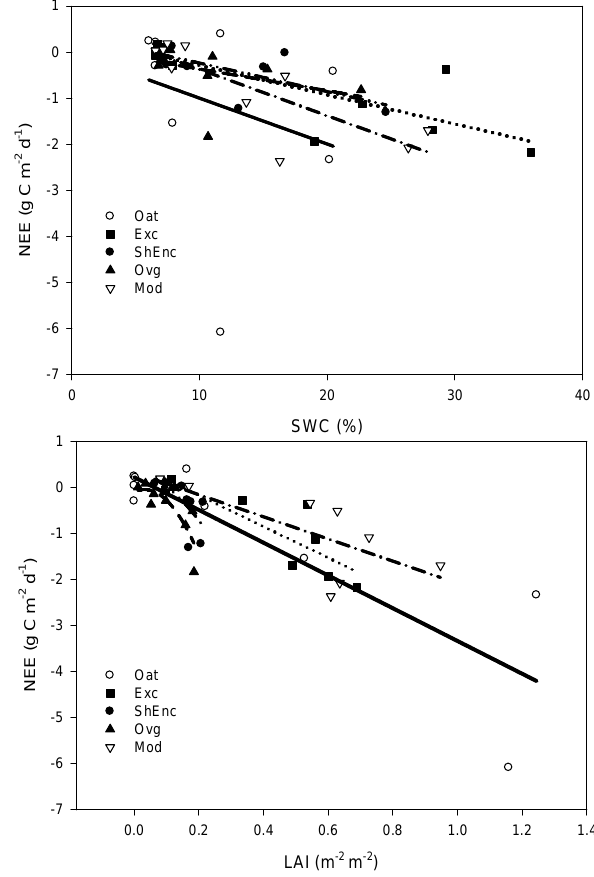
Fig. 7. (a) Linear regressions between daily daytime NEE and SWC in five contrasting land use change types measured during ten months. (b) Linear regressions between daily daytime NEE and LAI. Line symbols correspond to the following: ··· Exc, – · – Mod, –– Ovg, – ·· – ShEnc, and —– Crop. For explanations of abbrevia- tions, refer to Fig.